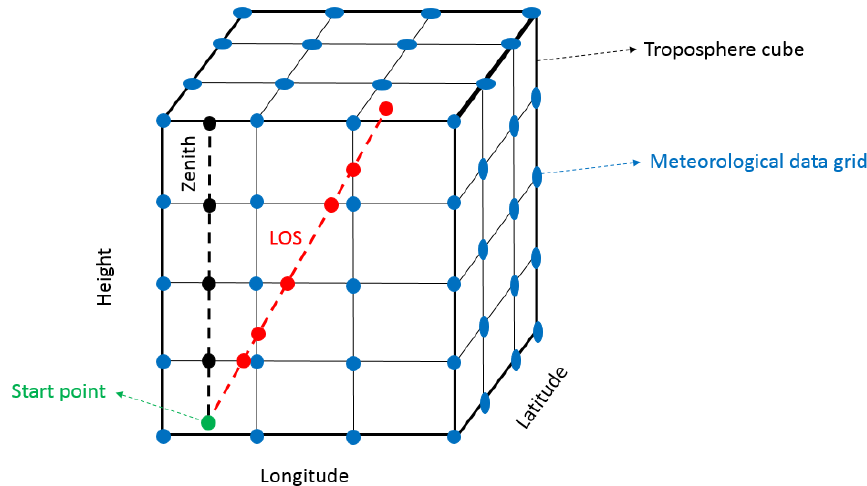
Figure 5. Difference between integration on the zenith and LOS directions.